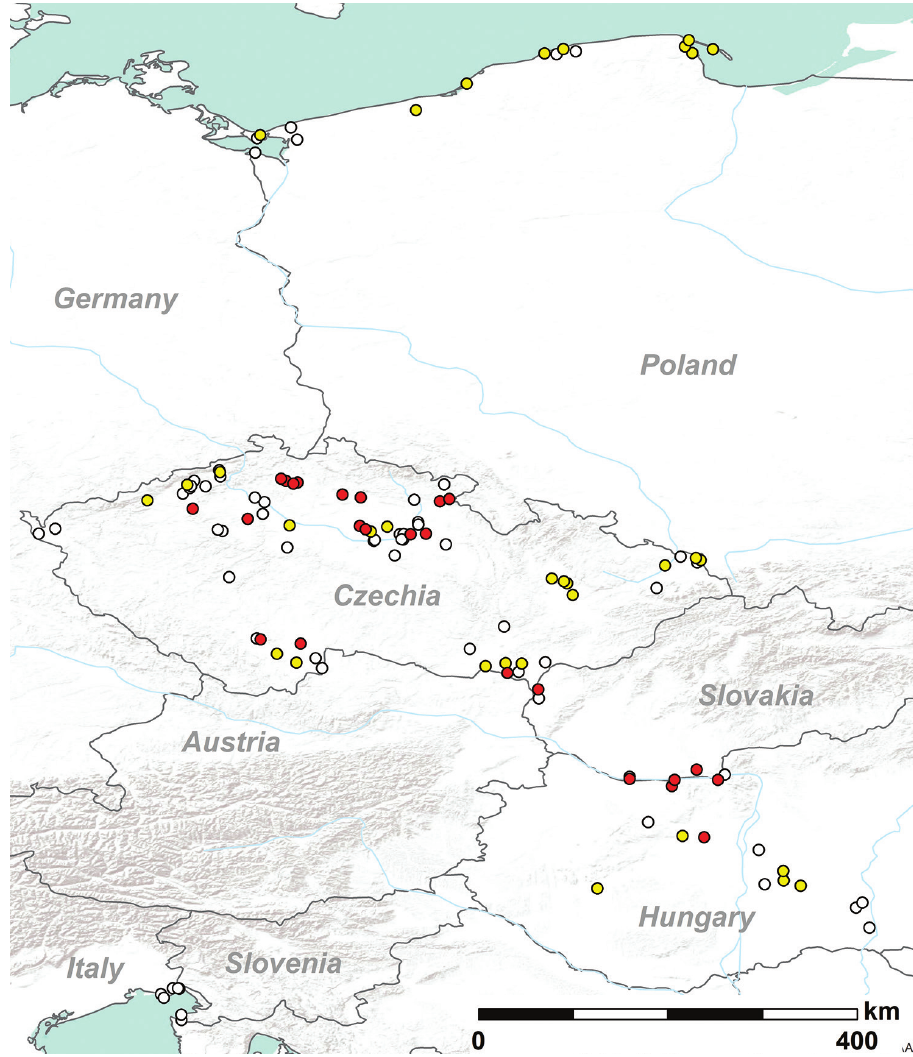
Figure 2. Map with occurrence of Hylaeus pectoralis (yellow) and Gasteruption phragmiticola together with Hylaeus pectoralis (red) in the localities studied. No localities of Gasteruption phragmiticola without the presence of H. pectoralis were recorded. Empty circles represent the localities where these species have not been